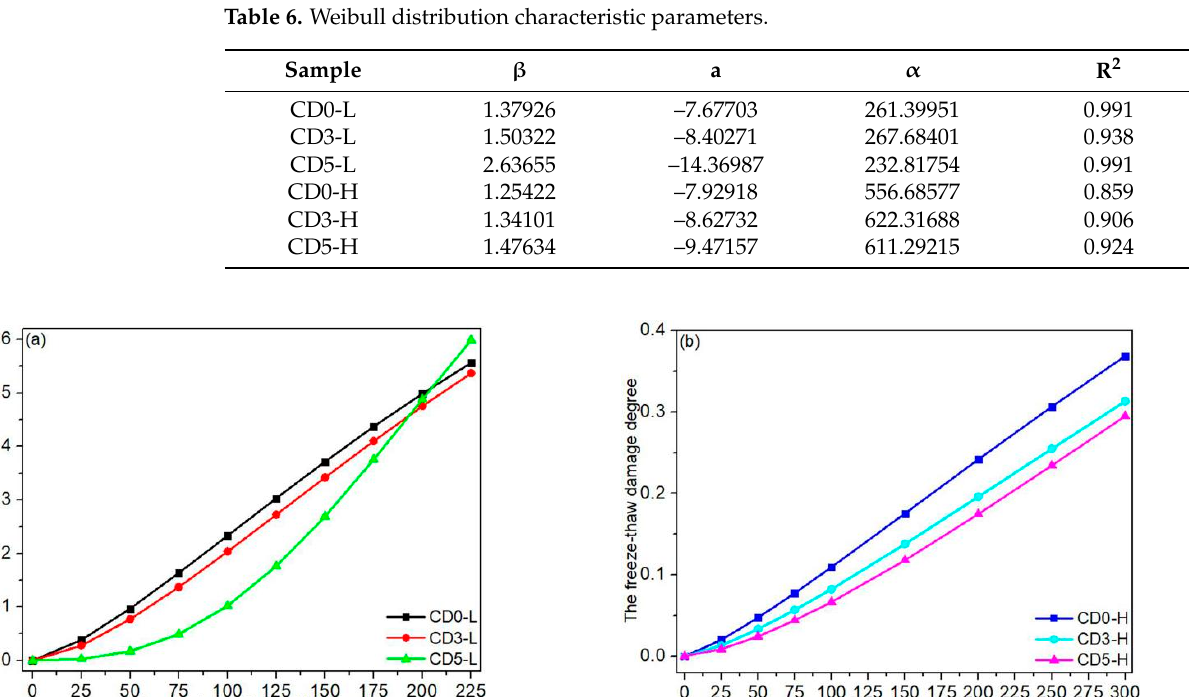
Figure 9. Evolution model of the damage degree of concretes for various replacement levels of dolomite powder: ( a ) C30 concretes; ( b ) C45 concretes.